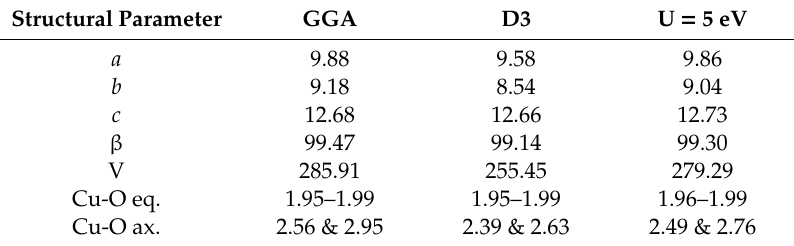
Table 2. Structural parameters a, b, c (Å), β ( ◦ ), Volume V (Å 3 / fu), and Cu–O equatorial and axial distances (Å) for di ff erent approximations: GGA, GGA + D3(BJ), and GGA + U (U Cu = 5 eV).